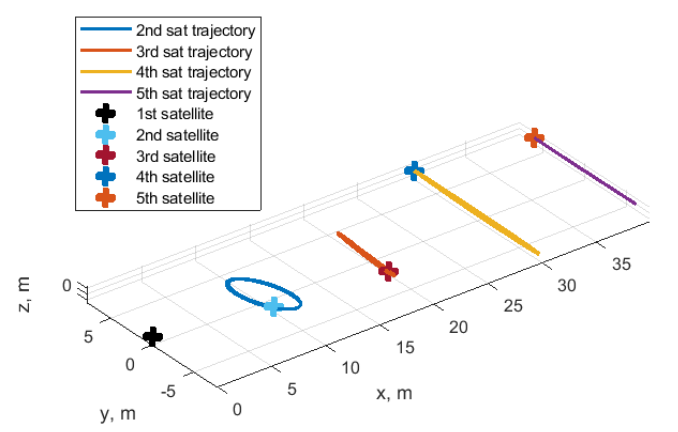
Figure 31. Relative trajectories during the last 2 h of